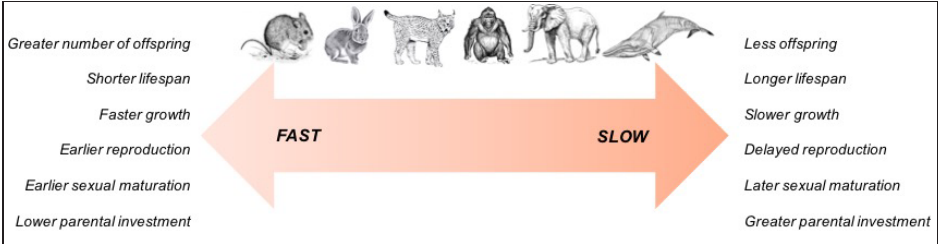
Figure 1: The fast-slow life-history continuum (adapted from Del Giudice & Ellis,